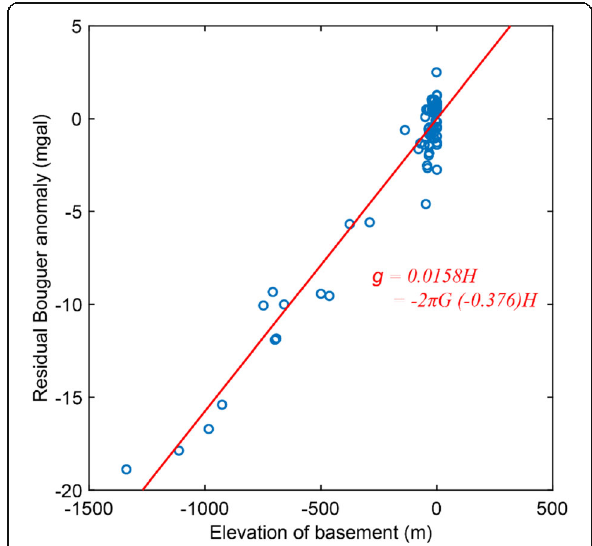
Fig. 5 Relationship between the elevation of the basement and the residual Bouguer anomaly at the boring site or basement exposure (Fig. 4). The red line represents the relationship between the elevation of the basement and the residual Bouguer anomaly by using the least square method